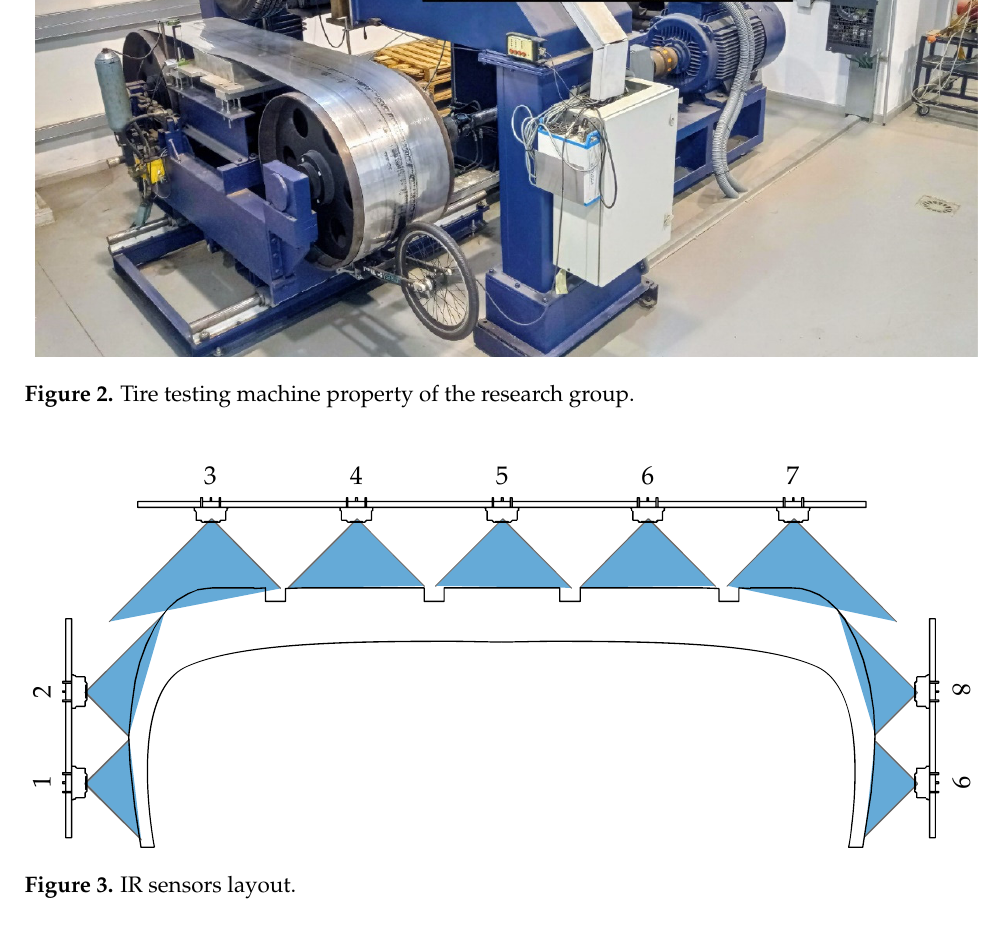
Figure 2. Tire testing machine property of the research group.